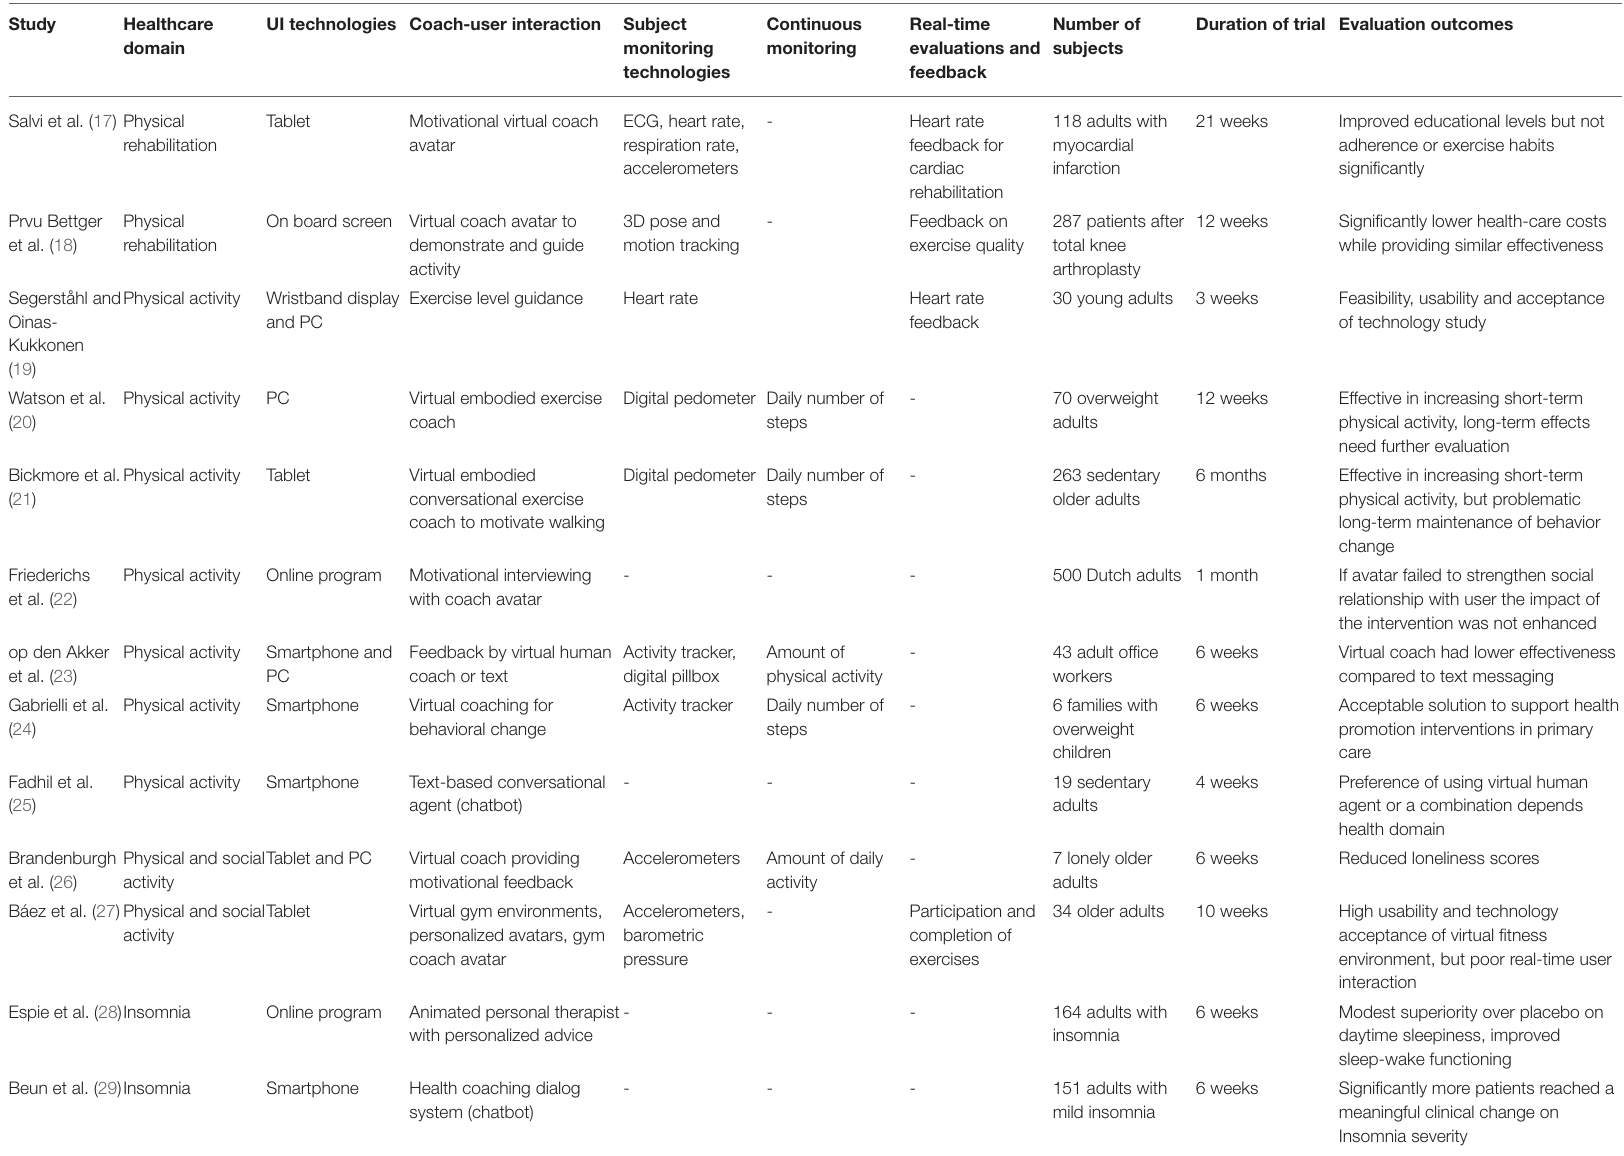
TABLE 1 | Coaching systems that were designed for and evaluated in home